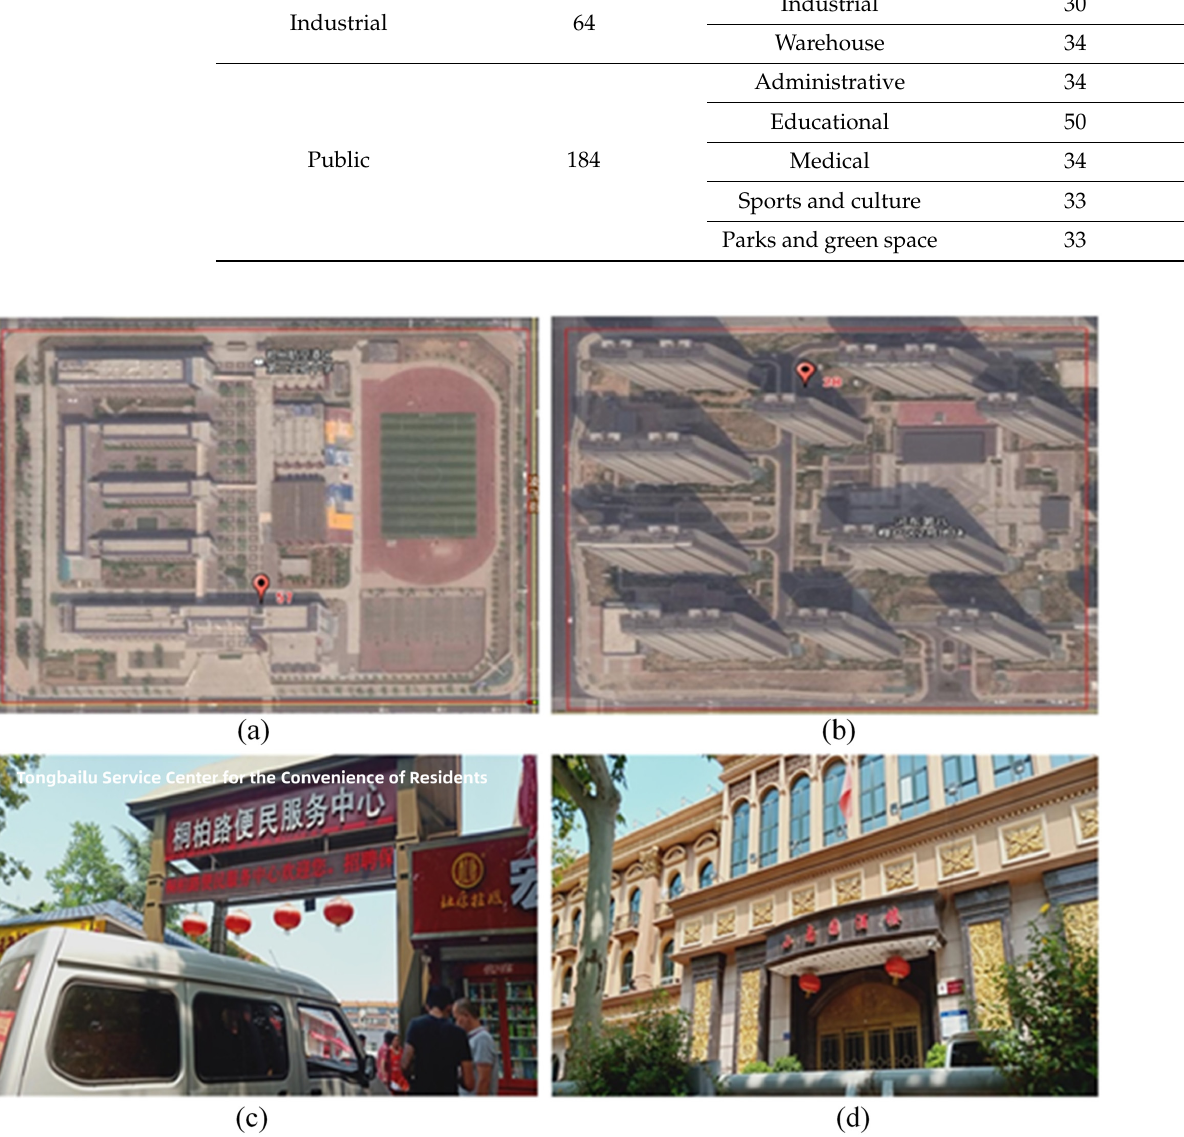
Figure 2. Example of a sample of features: ( a ) educational land, ( b ) residential land, ( c ) institutional land, and ( d ) commercial land. Table 2. Total sample size by feature type.